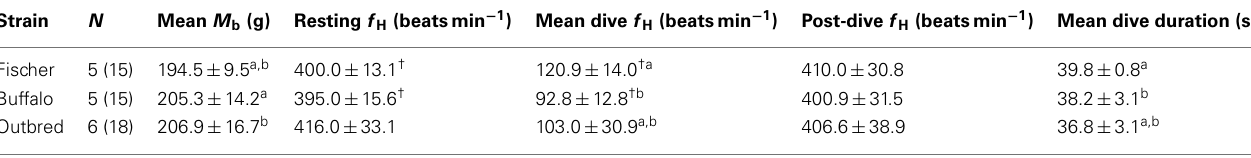
Table 1 |Total number of animals ( N ) performing three dives separated by at least 1day, mean ( ± SD) body mass (M b ), and mean resting heart rate (f H ) immediately before the dive for a total of three repeated forced dives performed on different days. One Fischer and one Buffalo rat completed only one dive experiment and their data are included.